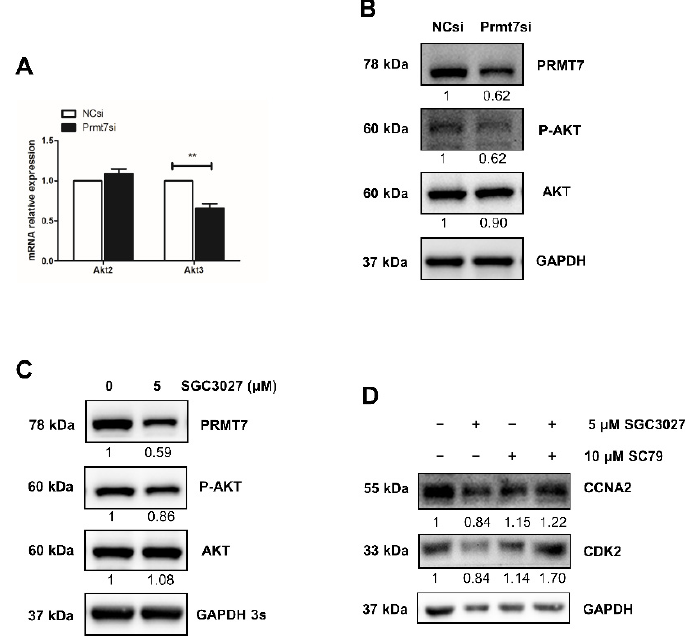
Figure 5. Apigenin/ Prmt7 / Akt3 pathway analysis in spermatogonial proliferation. ( A ) Relative mRNA expression of Akt2 and Akt3 was examined by RT-qPCR in spermatogonia transfected with NC and Prmt7 siRNA for 48 h. ( B , C ) The protein levels of PRMT7 and AKT as well as AKT phosphorylation (P-AKT) were detected by Western blotting in spermatogonia transfected with NC and Prmt7 siRNA ( B ) or treated with 0 and 5 μ M Prmt7 inhibitor SGC3027 for 48 h ( C ). ( D ) The protein levels of CCNA2 and CDK2 were detected by Western blotting in spermatogonia treated with 5 μ M Prmt7 inhibitor SGC3027 and 10 μ M AKT activator SC79 in different combination ways for the rescue assay. Data from three independent experiments are expressed as mean ± SEM. * indicates statistical significance. ** p < 0.01.